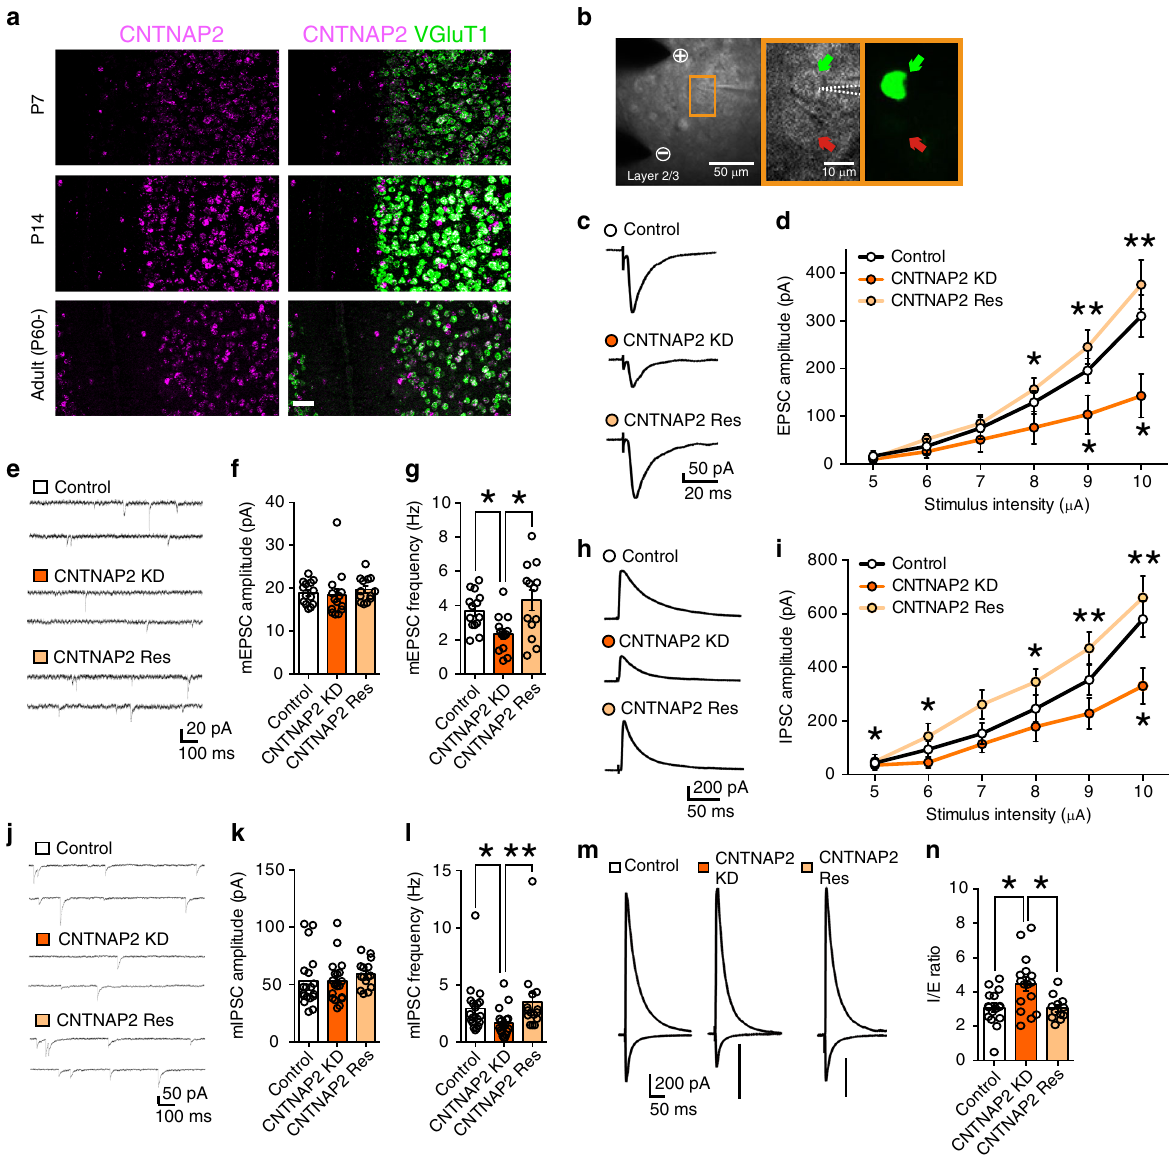
Fig. 1 Effects of CNTNAP2 knockdown in layer 2/3 pyramidal neurons of the PFC on synaptic function. a Images from double fl uorescence in situ hybridization for mRNA of CNTNAP2 and that of VGluT1 in layer 2/3 pyramidal neurons. Scale bar, 50 μ m. b Images of a recorded pyramidal neuron. Dashed white lines delineate the patch pipette. + and − show the anode and cathode, respectively, of the stimulation electrode. Bright fi eld (middle) and fl uorescent (right) images correspond to the orange rectangle in the left panel. Green and red arrows represent an EGFP-positive knockdown cell and an EGFP-negative control cell, respectively. c , d Traces ( c ) and input-output relationships ( d ) for EPSCs in control (white circles, n = 13 cells from 4 mice), CNTNAP2-knockdown (CNTNAP2-KD) (orange circles, n = 13 cells/4 mice) and CNTNAP2-rescue (CNTNAP2-Res) (light orange circles, n = 11 cells/4 mice) cells. e – g Traces of mEPSCs ( e ) and summary graphs showing the amplitude ( f ) and frequency ( g ) of mEPSCs for control (white columns, n = 14 cells/4 mice), CNTNAP2-KD (orange columns, n = 14 cells/4 mice) and CNTNAP2-Res (light orange columns, n = 13 cells/4 mice) cells. h , i Traces ( h ) and input-output relationships ( i ) for IPSCs in control (white circles, n = 17 cells/3 mice), CNTNAP2-KD (orange circles, n = 16 cells/3 mice) and CNTNAP2-Res (light orange circles, n = 13 cells/2 mice) cells. j – l Traces of mIPSCs ( j ) and summary graphs showing the amplitude ( k ), and frequency ( l ) of mIPSCs for control (white columns, n = 19 cells/6 mice), CNTNAP2-KD (orange columns, n = 19 cells/6 mice) and CNTNAP2-Res (light orange columns, n = 15 cells/3 mice) cells. m , n Traces ( m ) and the I/E ratio ( n ) for control (white column, n = 16 cells/5 mice), CNTNAP2-KD (orange column, n = 16 cells/5 mice) and CNTNAP2-Res (light orange column, n = 12 cells/3 mice) cells. *P < 0.05, **P < 0.01 (Dunn test). Data are mean ± SEM. Source data are provided as a Source Data fi le.